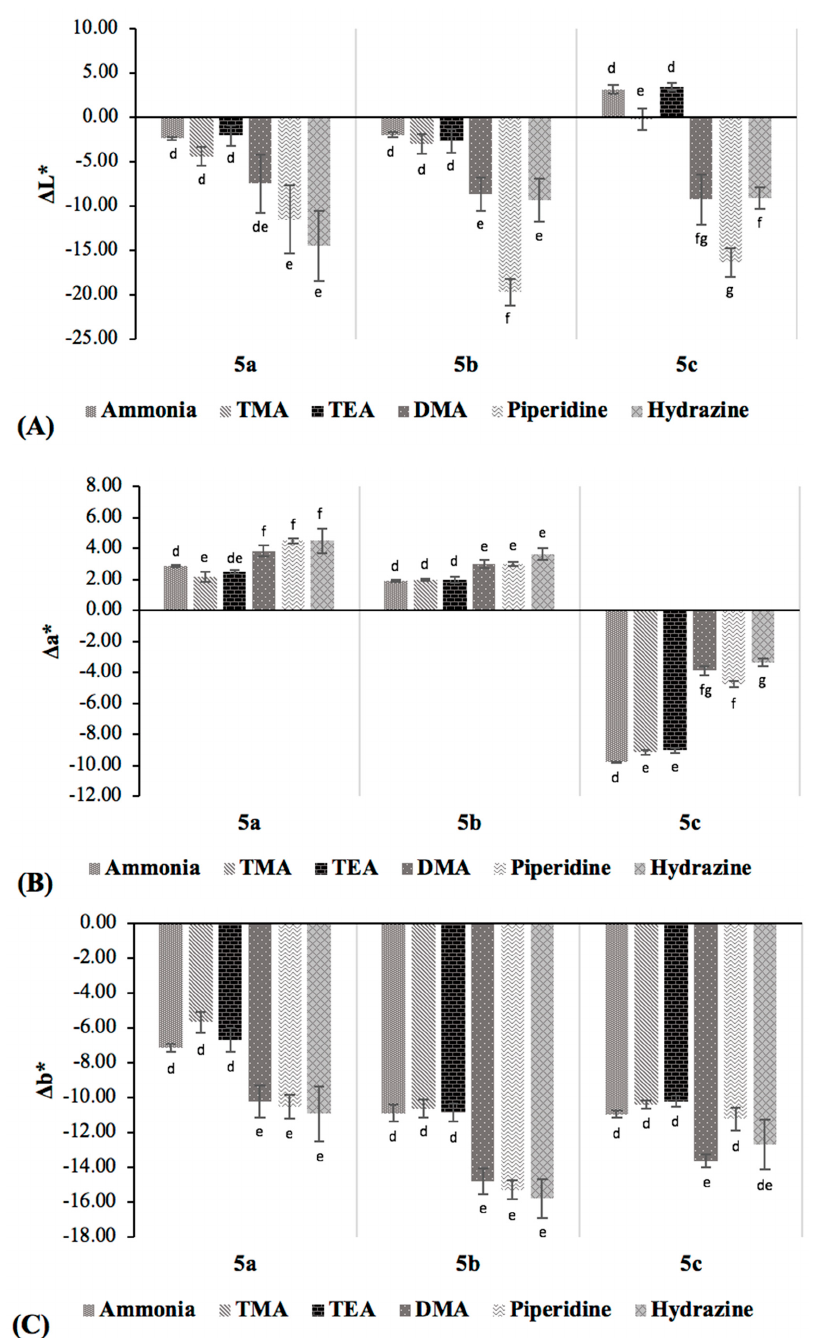
Figure 3. Changes of L * ( A ), a * ( B ), and b * ( C ) of acid-doped quinoxalines 5a – c before and after the exposure to amines. Columns labelled with different letters represent significant changes in color parameters for each of the indicator dyes ( p < 0.05). TMA: trimethylamine; TEA: triethylamine; DMA: dimethylamine.